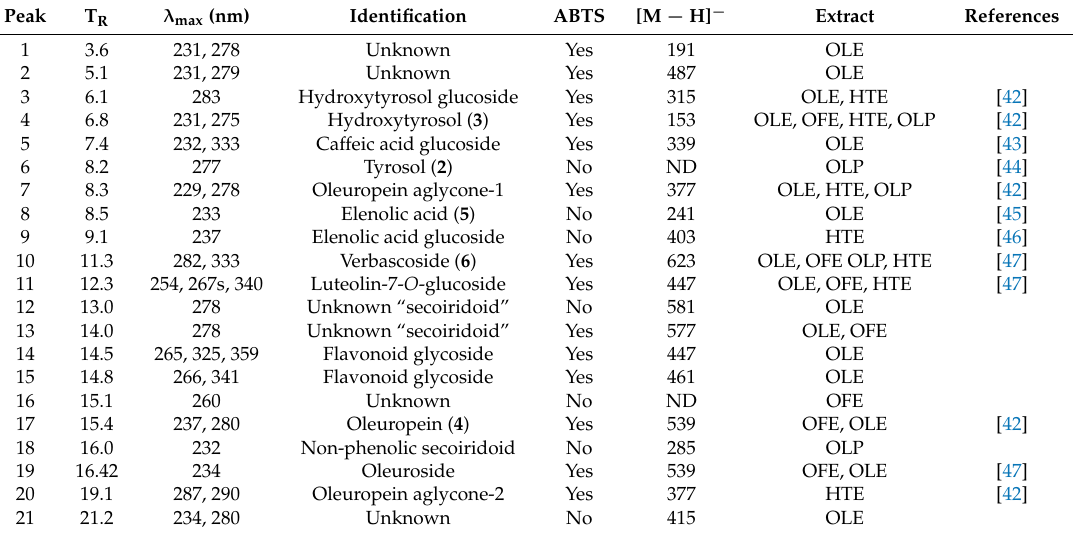
Table 1. Identification and online ABTS-scavenging activities of the principal peaks in olive extracts. Peak T